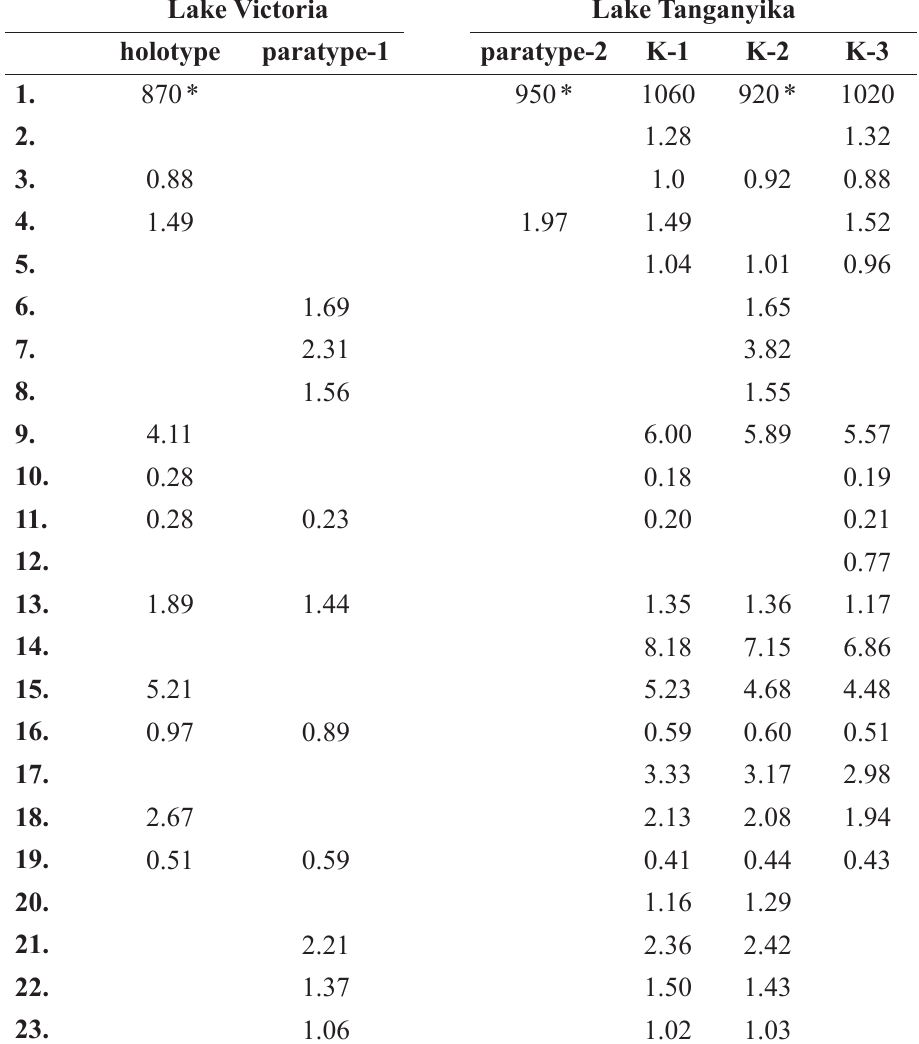
Table 4. Morphometric characters of the female in Eucyclops agiloides (G.O. Sars,1909). * Length of telescoping somites could not be measured separately; therefore, the total body length was measured as the sum of the length of the prosome and urosome. K-1, K-2 and K-3 refer to ♀-1, ♀-2 and ♀-3 from Kirando,